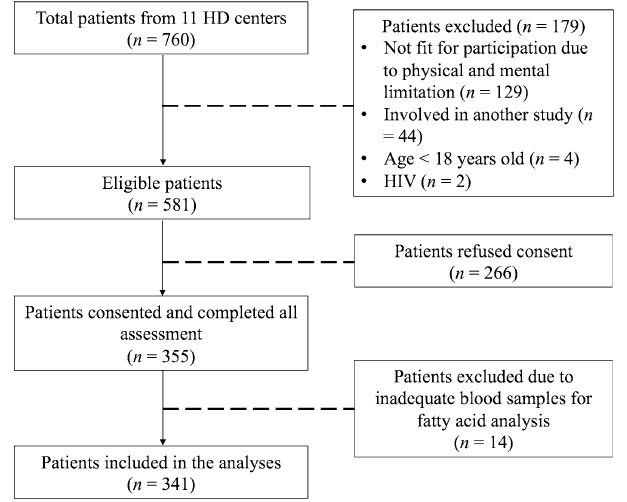
Figure 1. Flow chart of patient enrollment and analysis in this